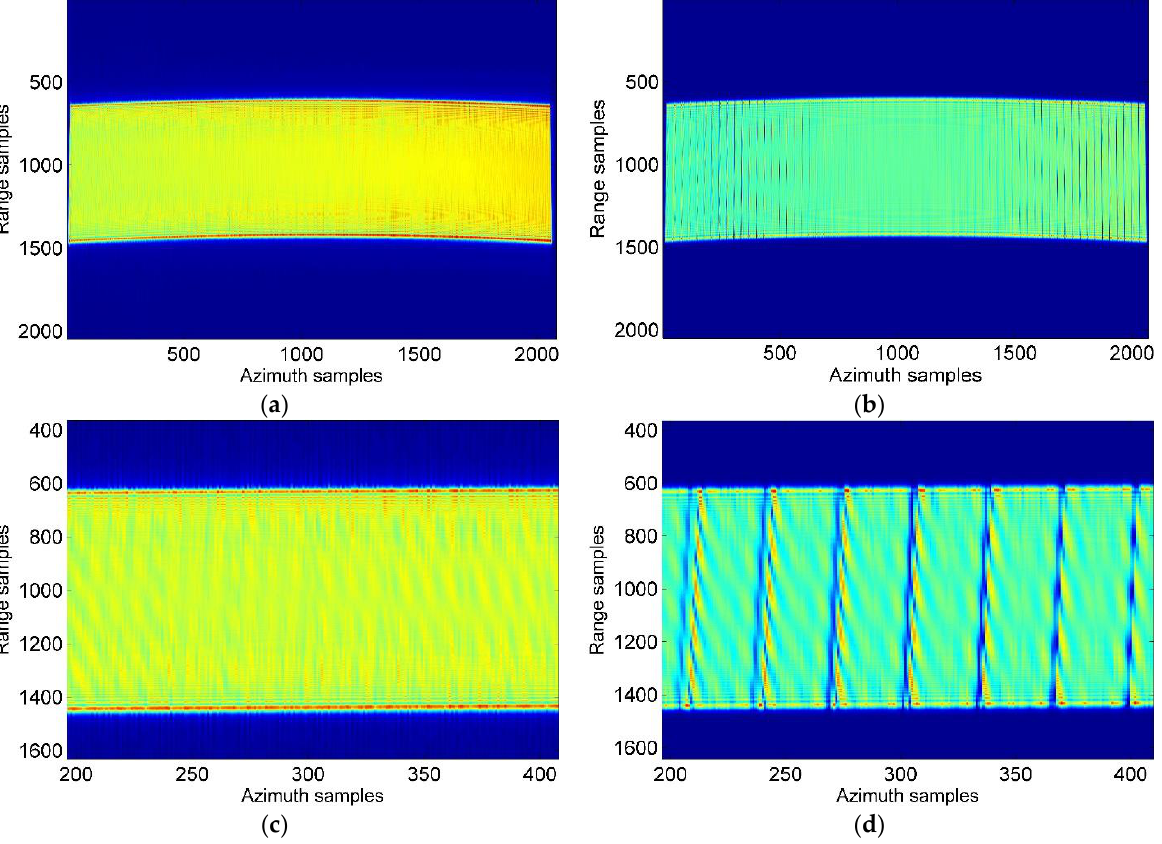
Figure 8. Spectrum fusion results of P 4 ; ( a ) the whole-aperture wavenumber spectrum in HSHD-AFBP, ( b ) the whole-aperture wavenumber spectrum in HS-AFBP, ( c ) the result of local position amplification in ( a ), ( d ) the result of local position amplification in ( b ).